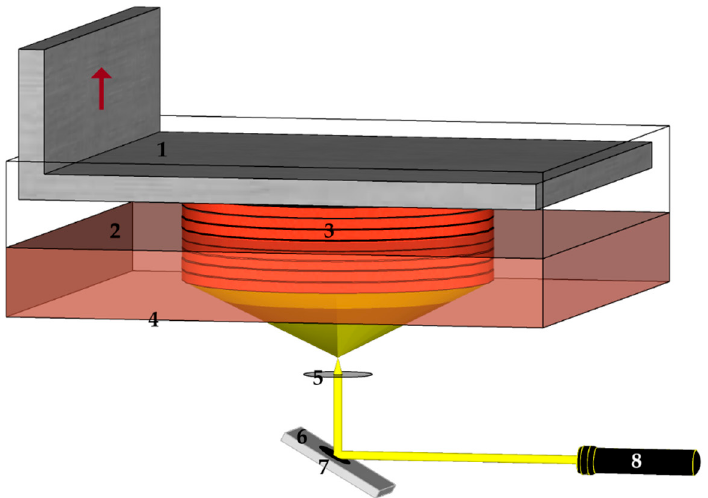
Figure 6. Vat Photopolymerization-based Digital Light Processing: 1—stage, 2—vat of resin, 3—part (cured resin), 4—transparent window, 5—lens, 6—digital mirror device, 7—pattern, 8—laser.